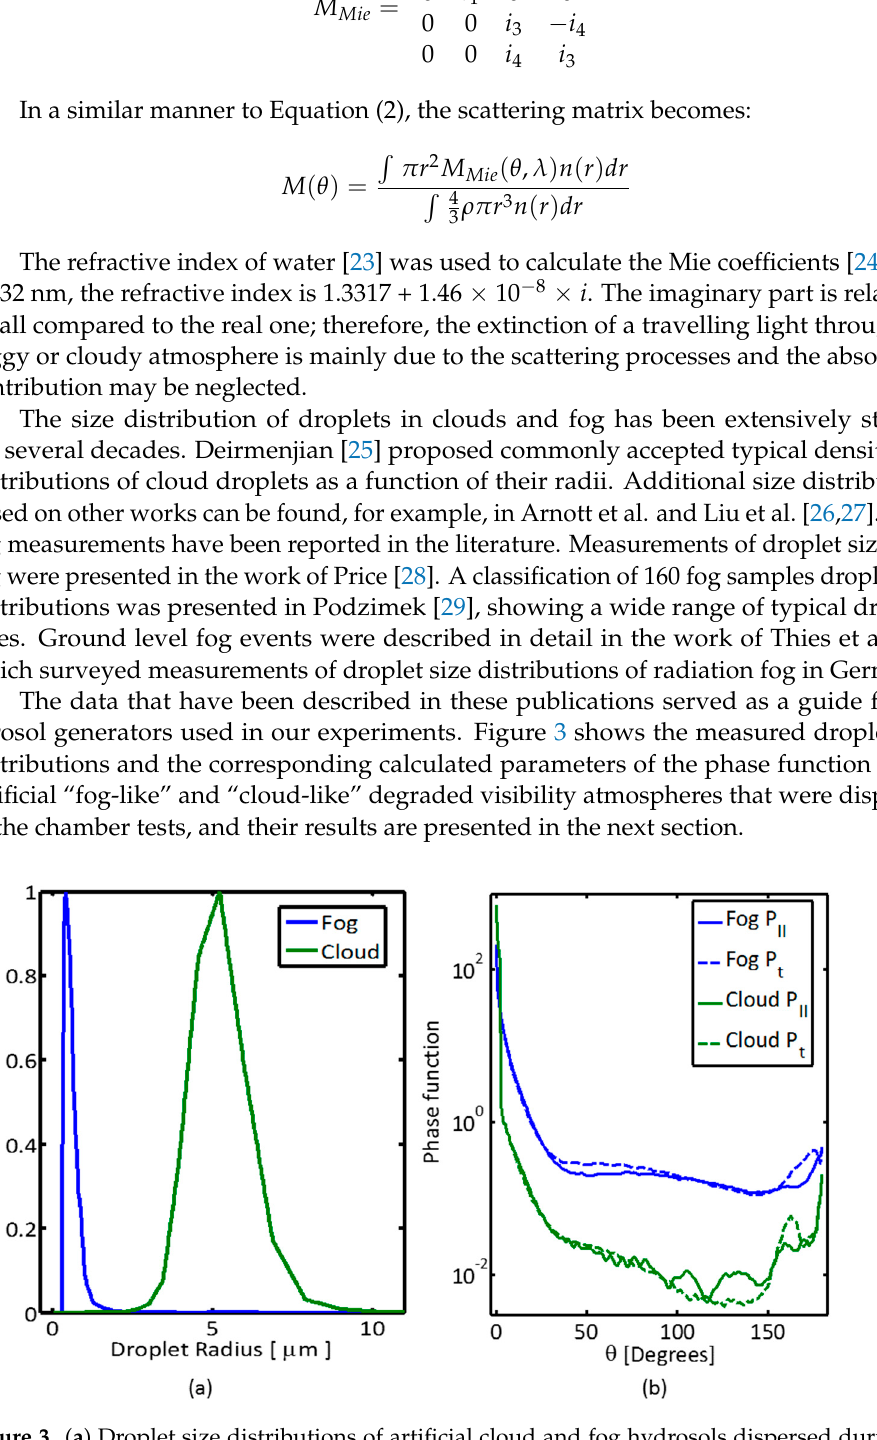
Figure 3. ( a ) Droplet size distributions of artificial cloud and fog hydrosols dispersed during the aerosol chamber experiments. ( b ) The phase function component angle dependences at λ = 632 nm that correspond to the distributions on the left-hand side (log-scale). The two polarization compo- nents, P II —parallel and P t —the orthogonal, are represented by full and dotted lines, respectively.